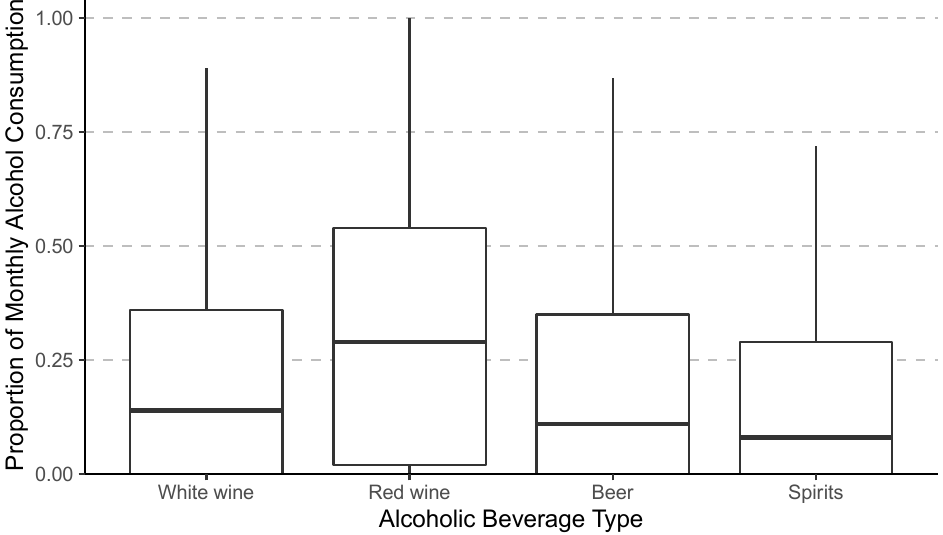
Figure A2. Boxplots showing the proportion of white wine, red wine, beer, and spirits consumed monthly ( n = 853).